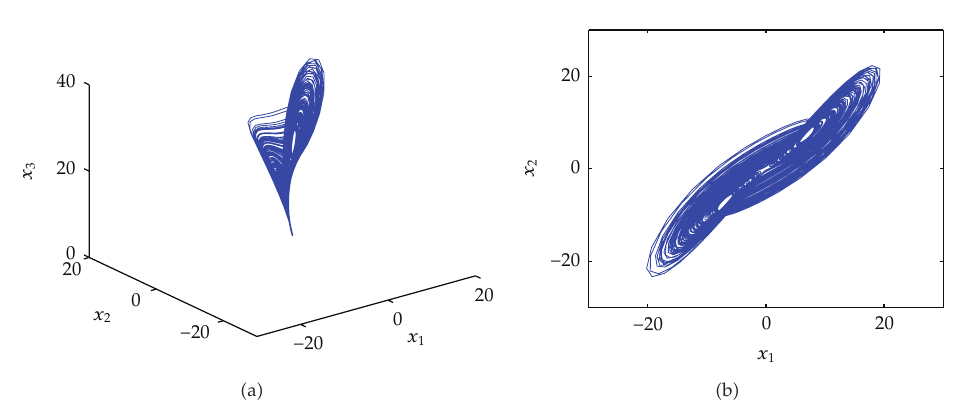
Figure 1: Chaotic attractor of fractional-order Chen chaotic system (cid:4) 3.1 (cid:5) for q (cid:7) 0 .